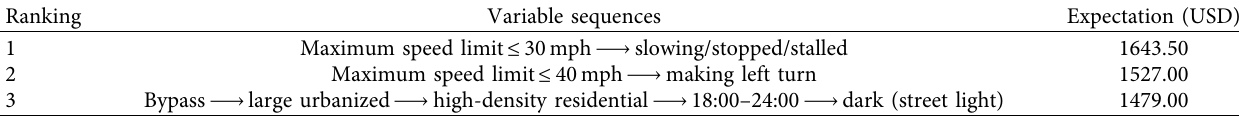
Table 5: Factor combination sequence result for property damage.